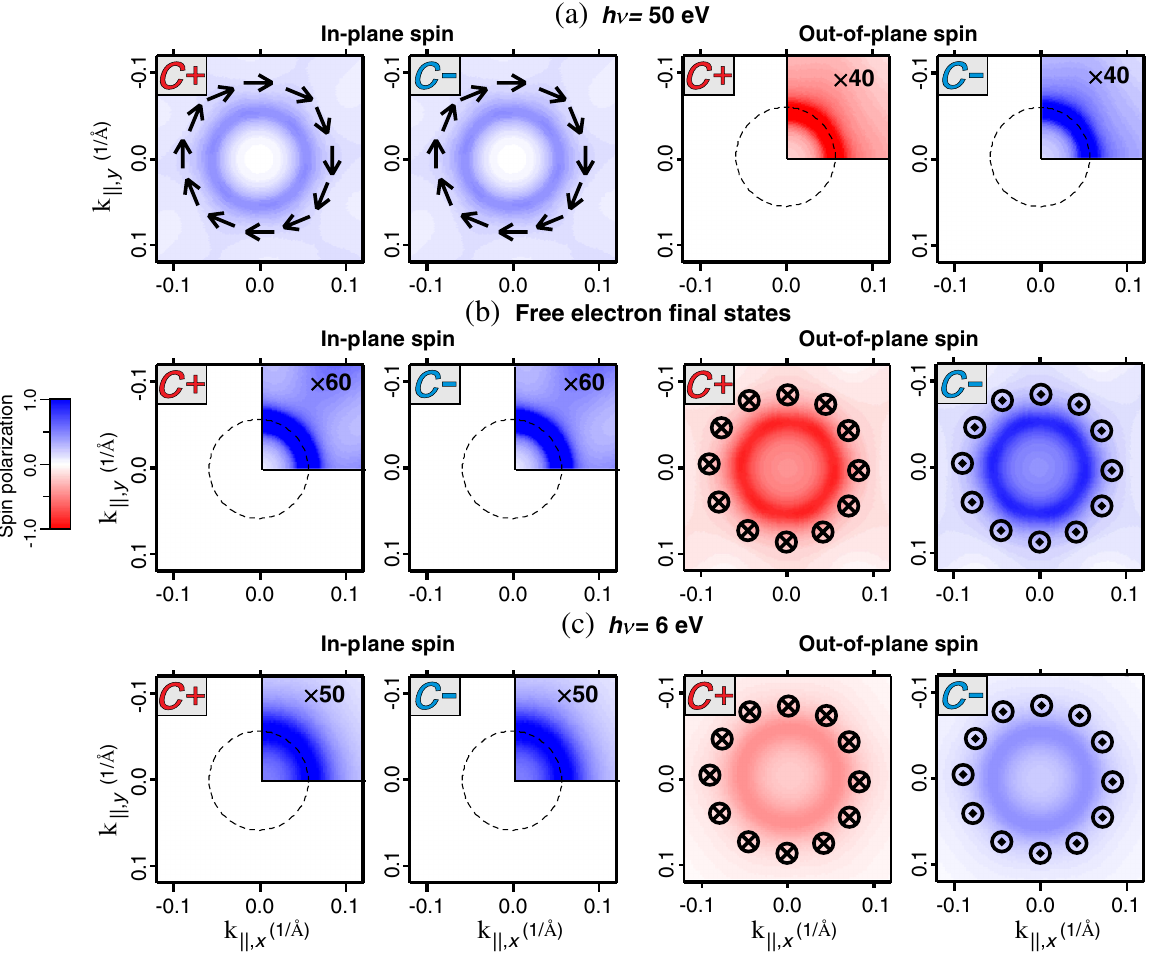
FIG. 4. Calculations of the in-plane (left panels) and out-of-plane (right panels) spin polarization of photoelectrons emitted from the TSS of Bi 2 Se 3 upon reversal of the light helicity from C þ to C − . The spin polarization is displayed on a constant-energy surface of circular shape above the Dirac point. (a) Results at 50 eVunder a 45° light-incidence angle, (b) for free-electron-like final states (300 eV) in normal incidence, and (c) at 6 eV again under a 45° light-incidence angle. Arrows in (a) indicate the in-plane spin-polarization directions, dots and crosses in (b) and (c) the spin polarization parallel and antiparallel to the surface normal, respectively. The color intensity is proportional to the magnitude of the spin polarization and has been magnified in the upper right quadrants in those panels where the in-plane [left panels in (b) and (c)] or the out-of-plane [right panels in (a)] spin polarization is nearly zero. Each quadrant is representative of the complete panel, as the results repeat symmetrically about the surface